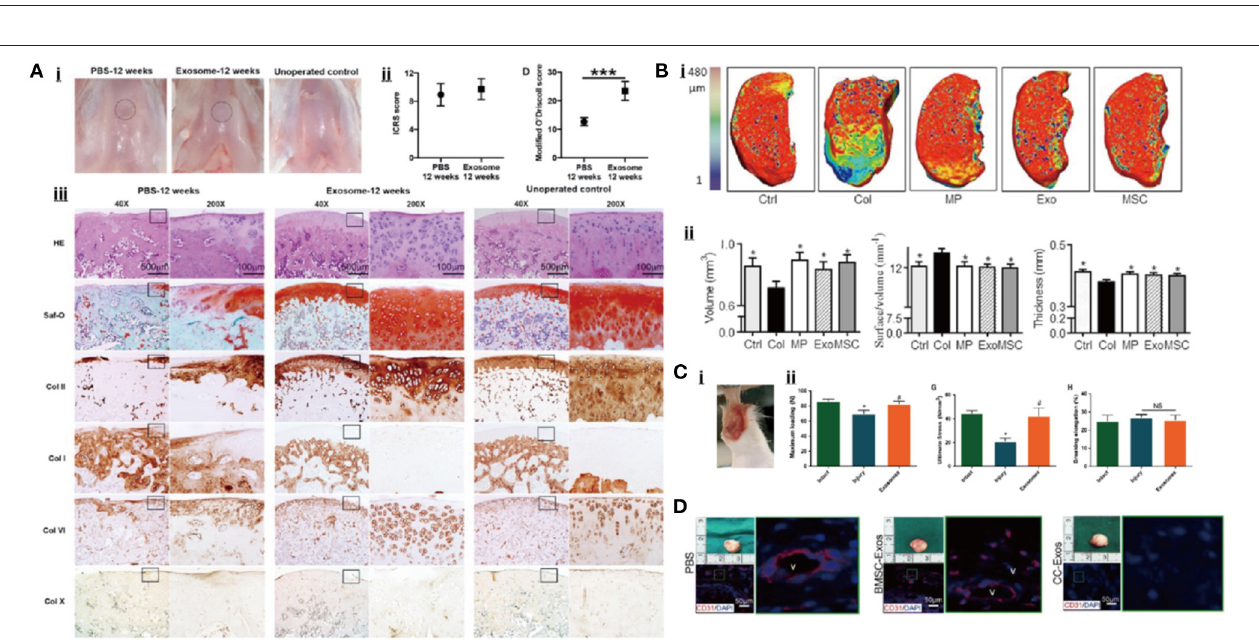
FIGURE 5 | The interaction between exosomes and chondrocytes. (A) Exosomes can promote chondrocyte migration and chondrogenic gene expression (Chen et al., 2020). (B) Exosomes can upregulate cellular growth and GAG secretion (Yan and Wu, 2020). (C) Exosome retention rate with hydrogel and cell uptake ( Viñuela-Berni et al., 2015).